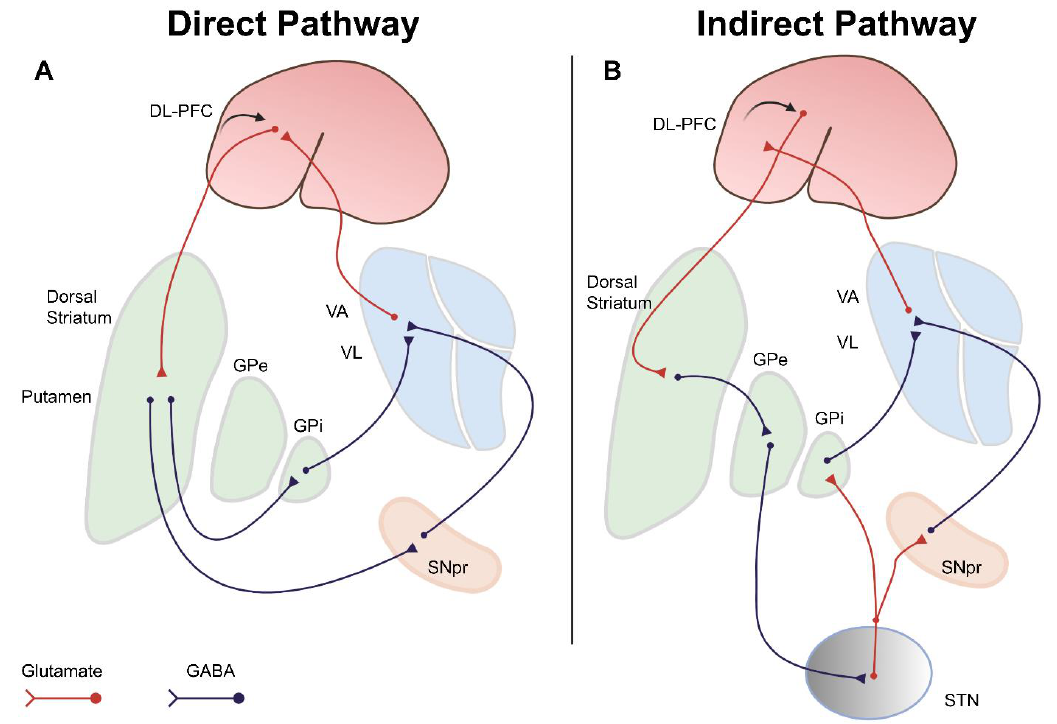
Figure 1. Direct and indirect pathways in the basal ganglia. Two principal pathways in the basal ganglia are involved in the selection of the motor plans. Excitatory pathways (glutamatergic) are shown in red, and inhibitory pathways (GABAergic) are shown in black. ( A ) The direct pathway employs the disinhibitory (GABA to GABA) pathway that provides signals from the putamen to the GPi/SNpr, leading to the activation of the thalamus that, in turn, stimulate the cortex. Through these connections, the direct pathway intensifies the motor plan prepared by the cortex. ( B ) In contrast, the indirect pathway employs the circuit composed of “inhibitory-stimulatory-inhibitory” connections to convert stimulatory corticostriatal glutamatergic input into inhibitory signals to the thalamus. The indirect pathway begins at the putamen, goes through the GPe, arrives at the STN, and then projects to the GPi/SNpr. The GPi/SNpr are connected to the thalamus, but the thalamic sites connected to the indirect pathway are different from the sites used by the direct pathway. Through these connections, the indirect pathway discourages motor plans other than those prepared by the cortex. GPi, globus pallidus internus; GPe, globus pallidus externus; SNpc, substantia nigra pars compacta; SNpr, substantia nigra pars reticulata; STN, subthalamic nucleus. Figures created with https://biorender.com/ (accessed on 4 March 2021).